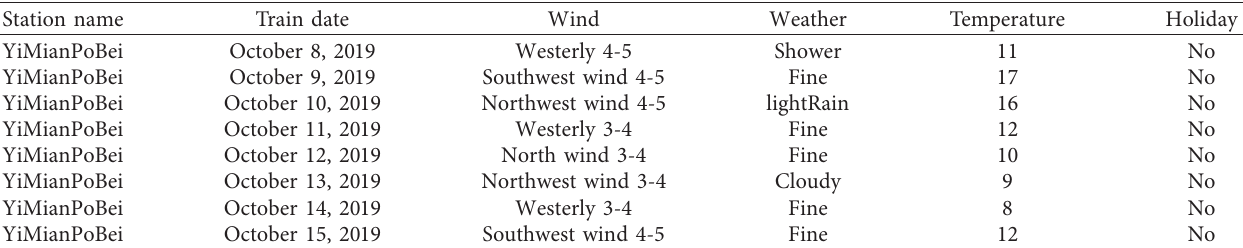
Table 3: Historical weather data and holiday data (before